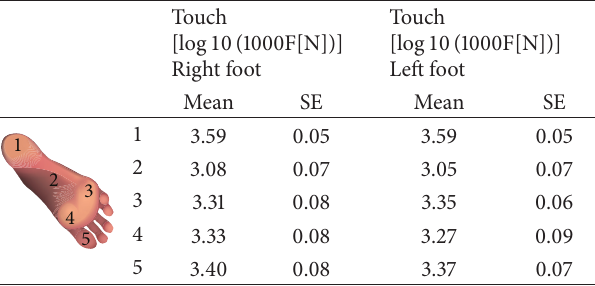
Table 2: Mean and standard error (SE) for all 24 subjects in the normal condition. The values are the baseline measurements (“before WBV”) for each site on the tested foot (1: heel, 2: mid-foot, 3: 5th metatarsal head, 4: 1st metatarsal head, and 5: